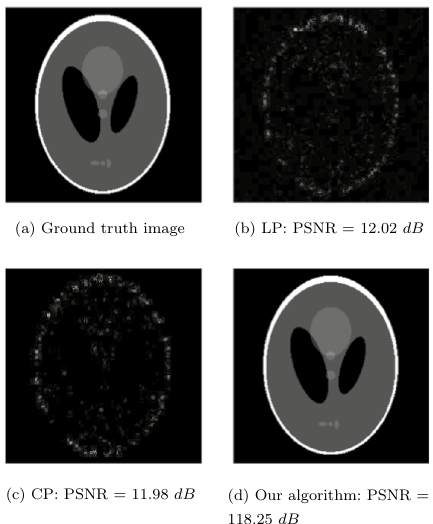
Fig. 5 Simulation results for reconstruction of the Shepp–Logan phantom image (phantom(256) in MATLAB) 32 blocks and each algorithm get m in which the picture split to 32 ×